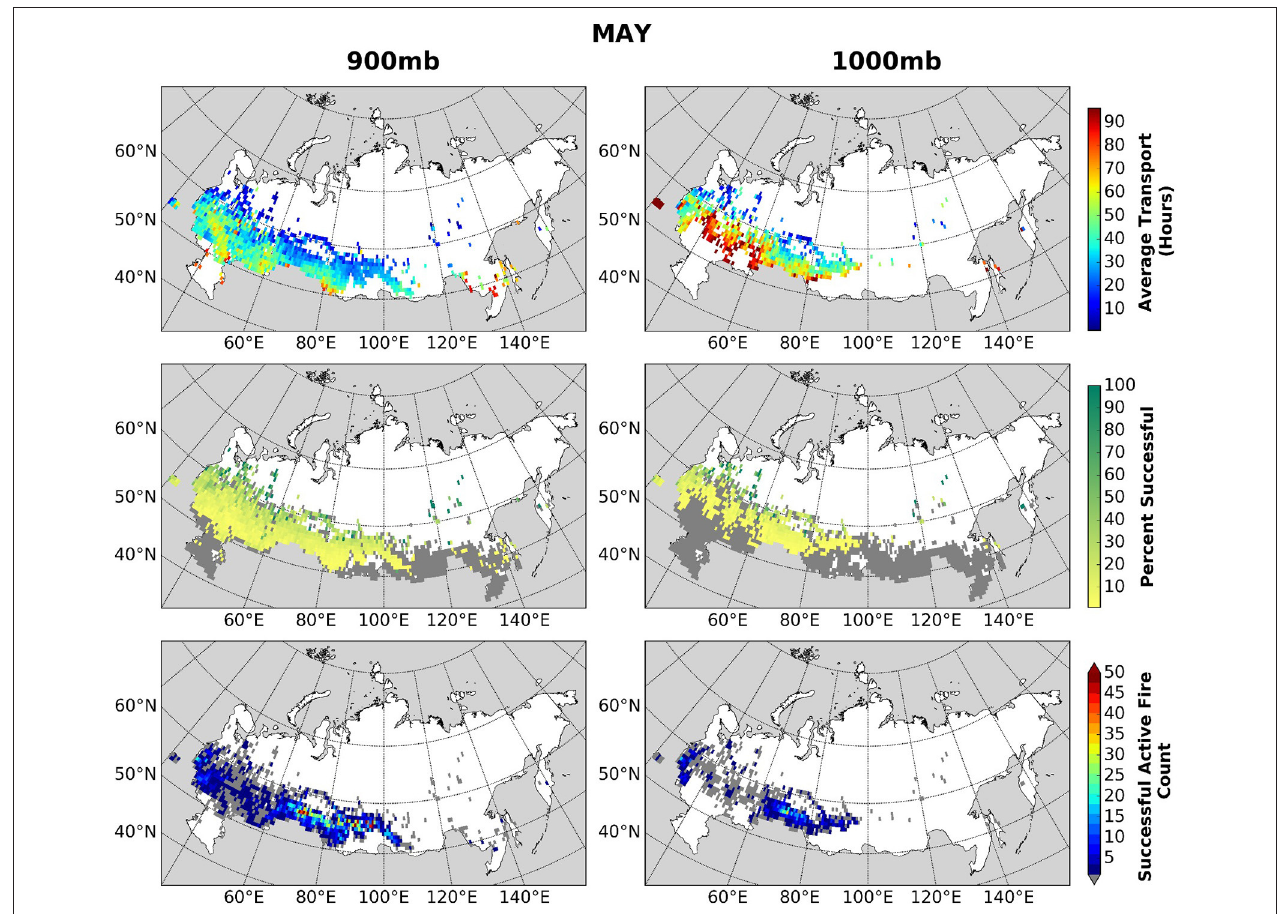
FIGURE 8 | 900 and 1,000mb May 2003–2015 average transport (hours), percent successful and active fires potentially contributing to BC deposition on snow in the Arctic. The dark gray color in the percent successful maps (middle) represents the starting fire locations which were unsuccessful at reaching the snow in the Arctic within